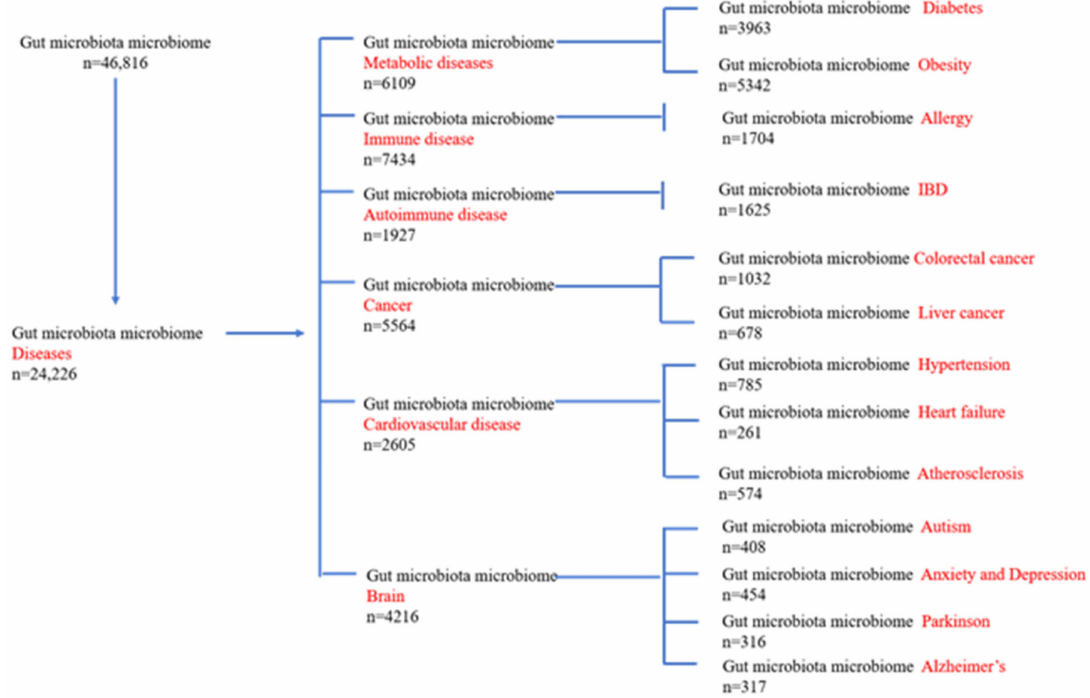
Figure 1. A PRISMA flow diagram of articles in PUBMED for gut microbiota. Texts in the diagram are used in search item and number (n) of articles showed up in